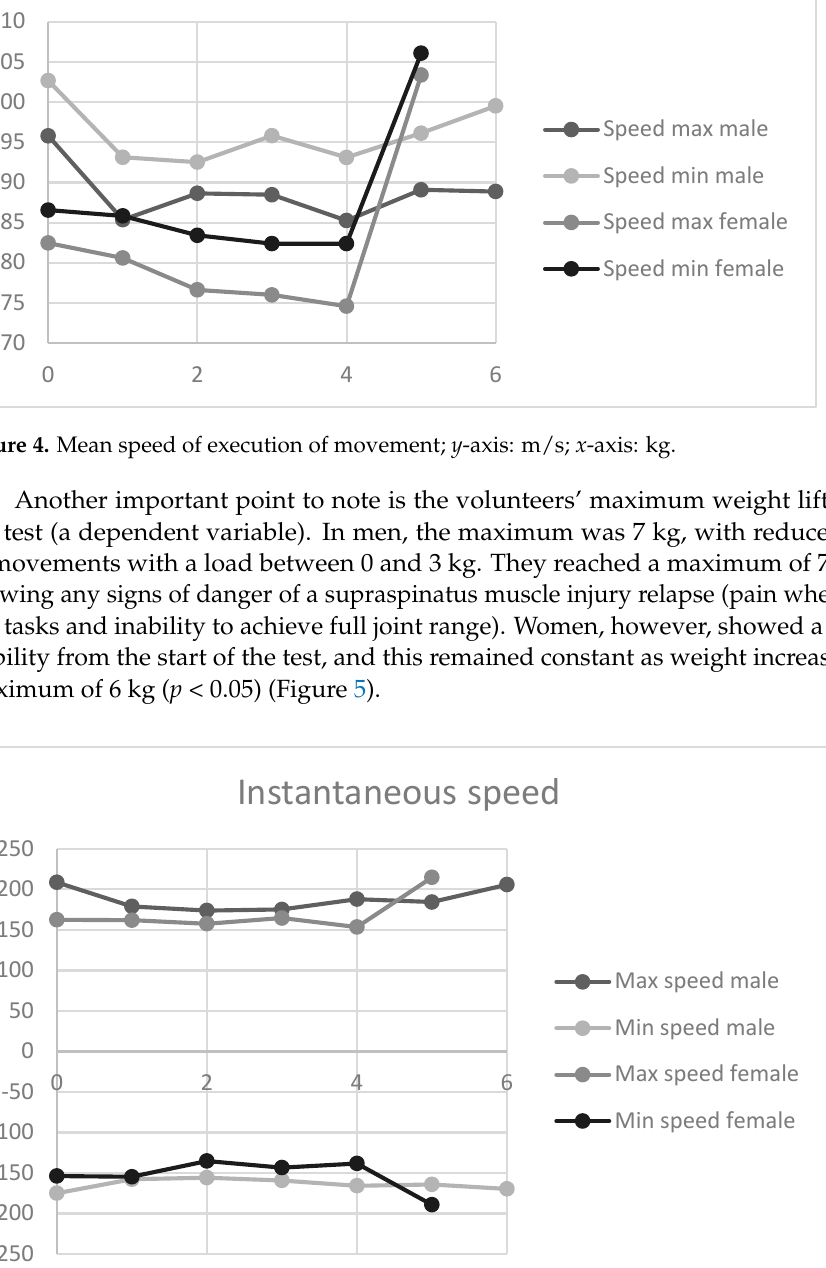
Figure 5. Instantaneous speed of execution of movement; y -axis: m/s. Shoulder abduction movement; y -axis: kg.